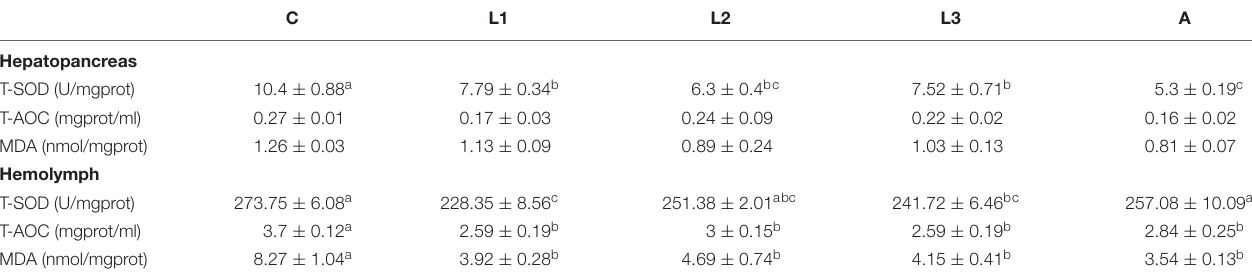
TABLE 4 | Hepatopancreas and hemolymph antioxidant parameter of L. vannamei fed diet supplementation with/without lutein or astaxanthin for 56 days. C L1 L2 L3